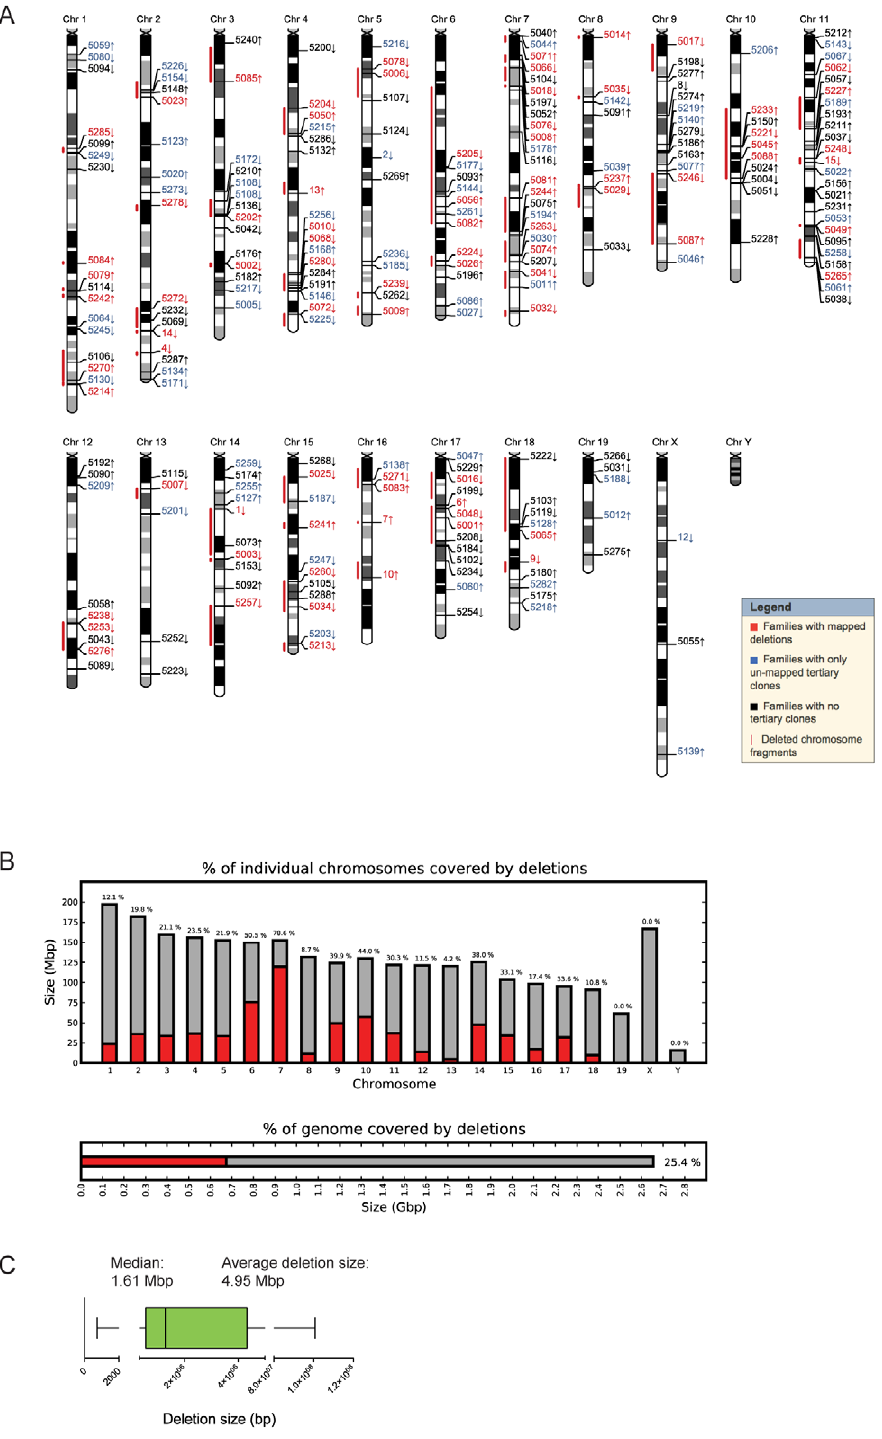
Figure 2. Molecular characterization of DelES clones. (A) Karyoview representation of anchor virus integration site and coverage of the longest deletion (red bar) mapped for each family of clones. The arrow indicates the predicted deletion orientation relative to the specific anchor site. (B) Genome-wide coverage of deletions mapped in DelES clones. Haploid deletions are mapped to most autosomes, covering more than 25% of the murinegenome. (C)Boxplot representing the sizedistributionassociated to 95%of mapped deletions. Averageandmedian deletion sizes are indicated. doi:10.1371/journal.pgen.1001241.g002 (470/540), ultraconserved elements (241/277), LINE/SINE protein-coding and non-coding sequences are well represented in (648571/602886), cancer related genes (108/104) and large deletions that are currently mapped. Moreover, clustering of cancer-associate deletions (5/7). Thus, several categories of specific genomic determinants has been reported [18,24–26]. As